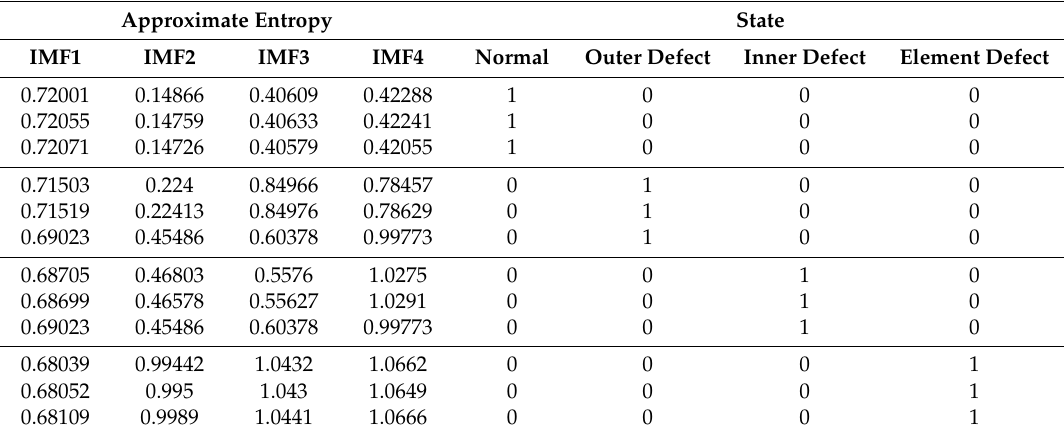
Table 4. Training data for each state.